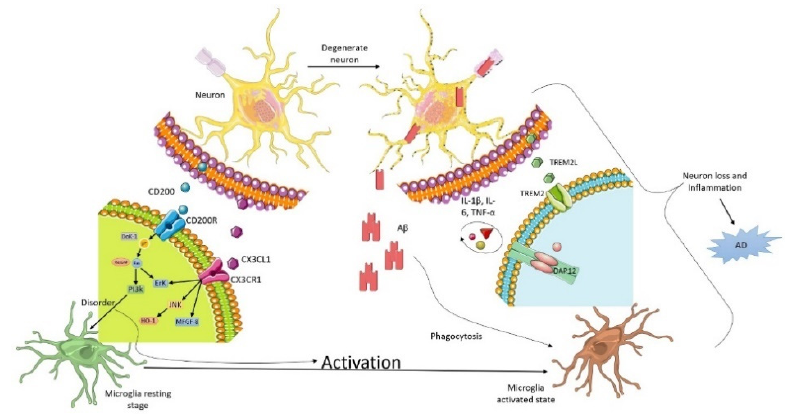
Figure 1. Microglia and neuron communication in AD pathology. 3. Triggering Receptors Expressed on Myeloid Cell-2 (TREM2)